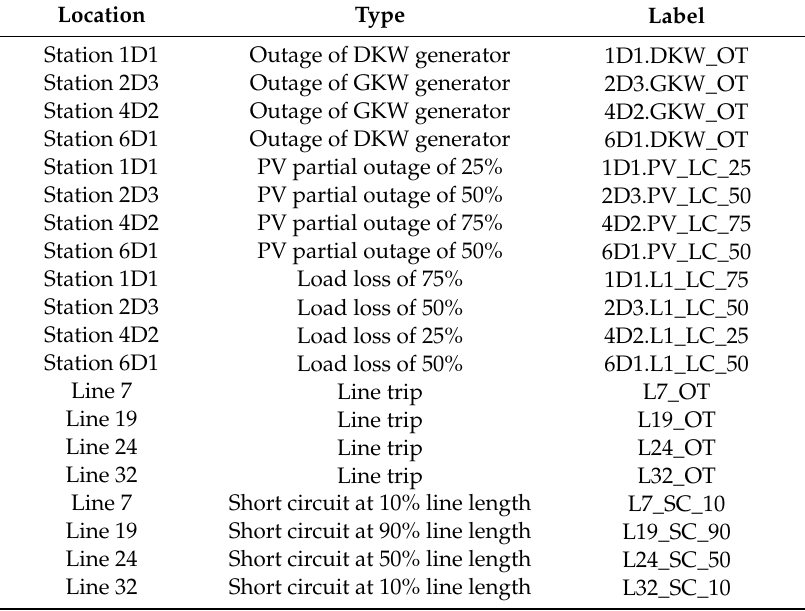
Table 10. Class configuration containing disturbance locations and types.